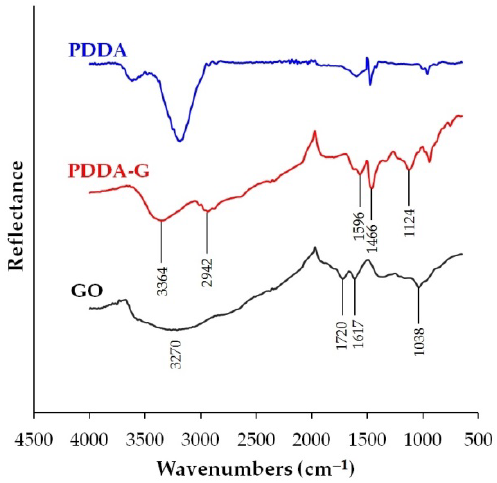
Figure 3. FT-IR spectra of GO, PDDA, and PDDA-G.